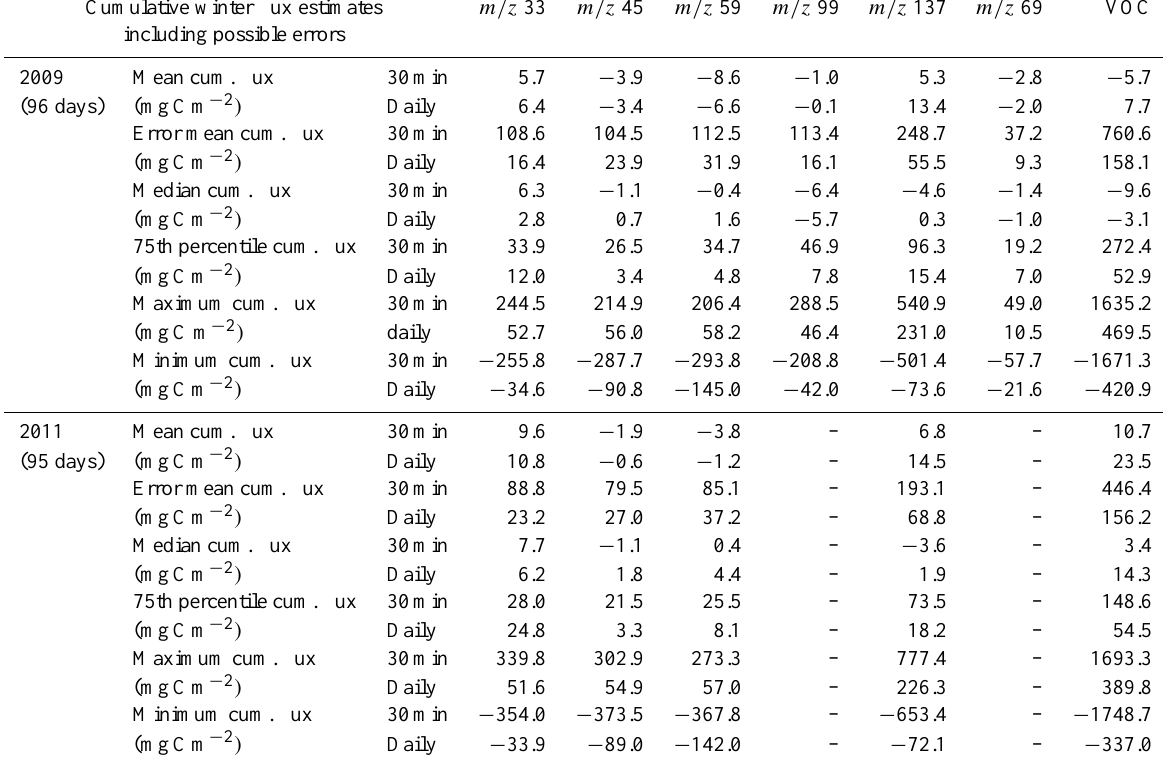
Table 3. Cumulative VOC fluxes for the winter period not covered by measurements (96 days in 2009 and 95 days in 2011) including cor- responding errors calculated on a diurnal/half-hourly basis for the years 2009 and 2011. The winter fluxes were gap-filled using mean/mean diurnal cycles and median/median diurnal cycles (calculated from measurements during snow-lying days). In addition the estimated values for the maximum and minimum cumulative fluxes for the winter data are